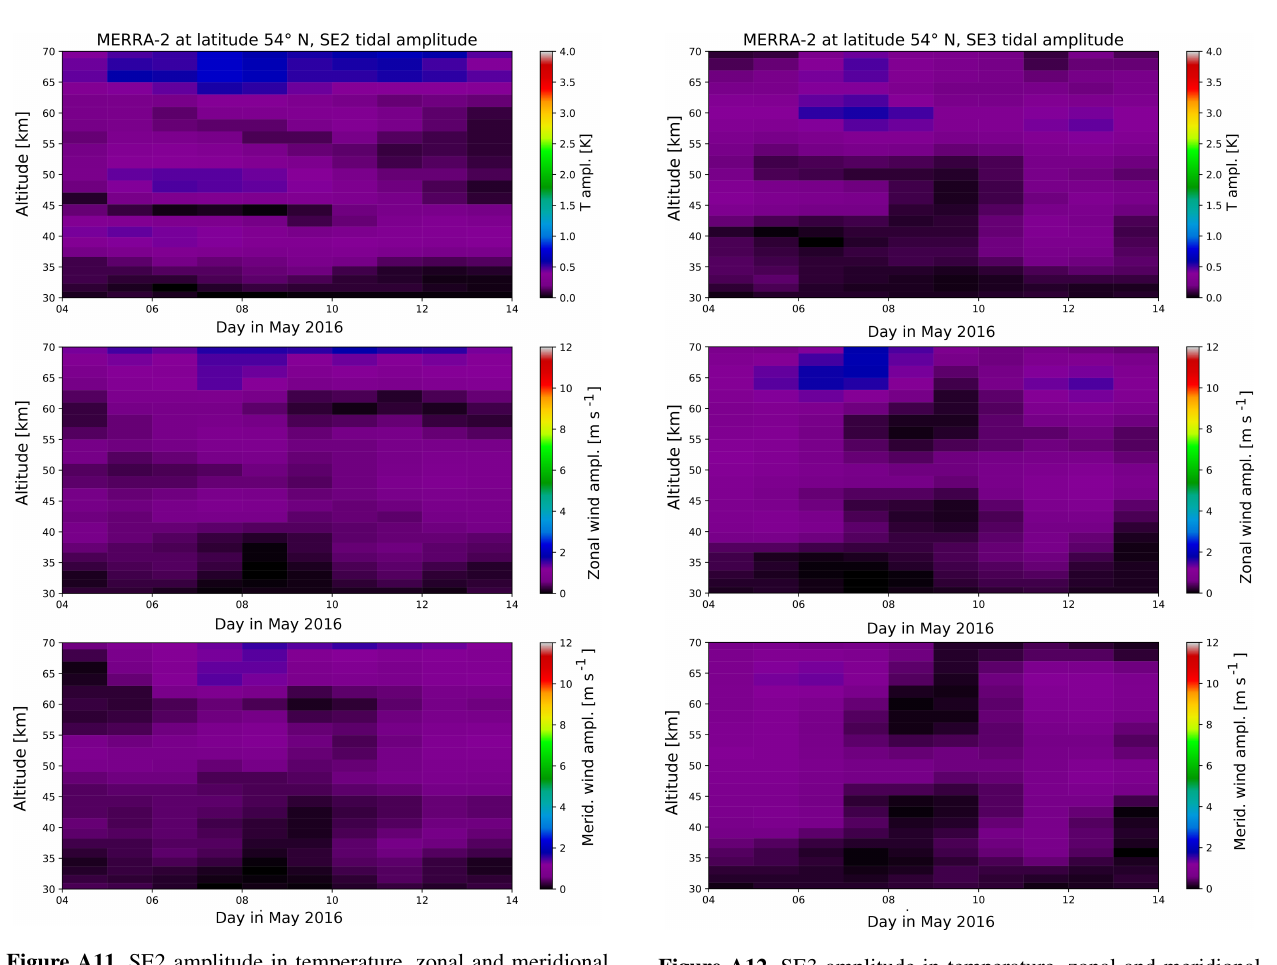
Figure A12. SE3 amplitude in temperature, zonal and meridional wind from global MERRA-2 fields at the latitude of 54 ◦